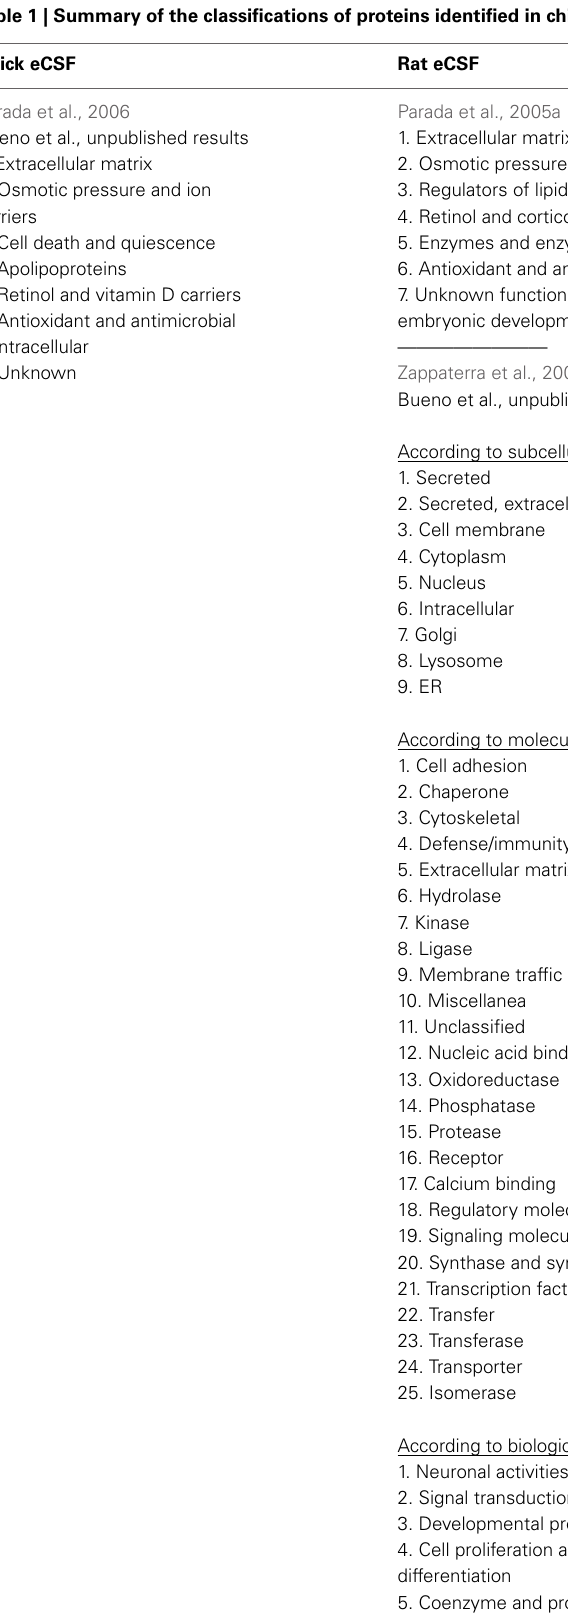
Table 1 | Summary of the classifications of proteins identified in chick, rat and human eCSF proteomes. Chick eCSF Rat